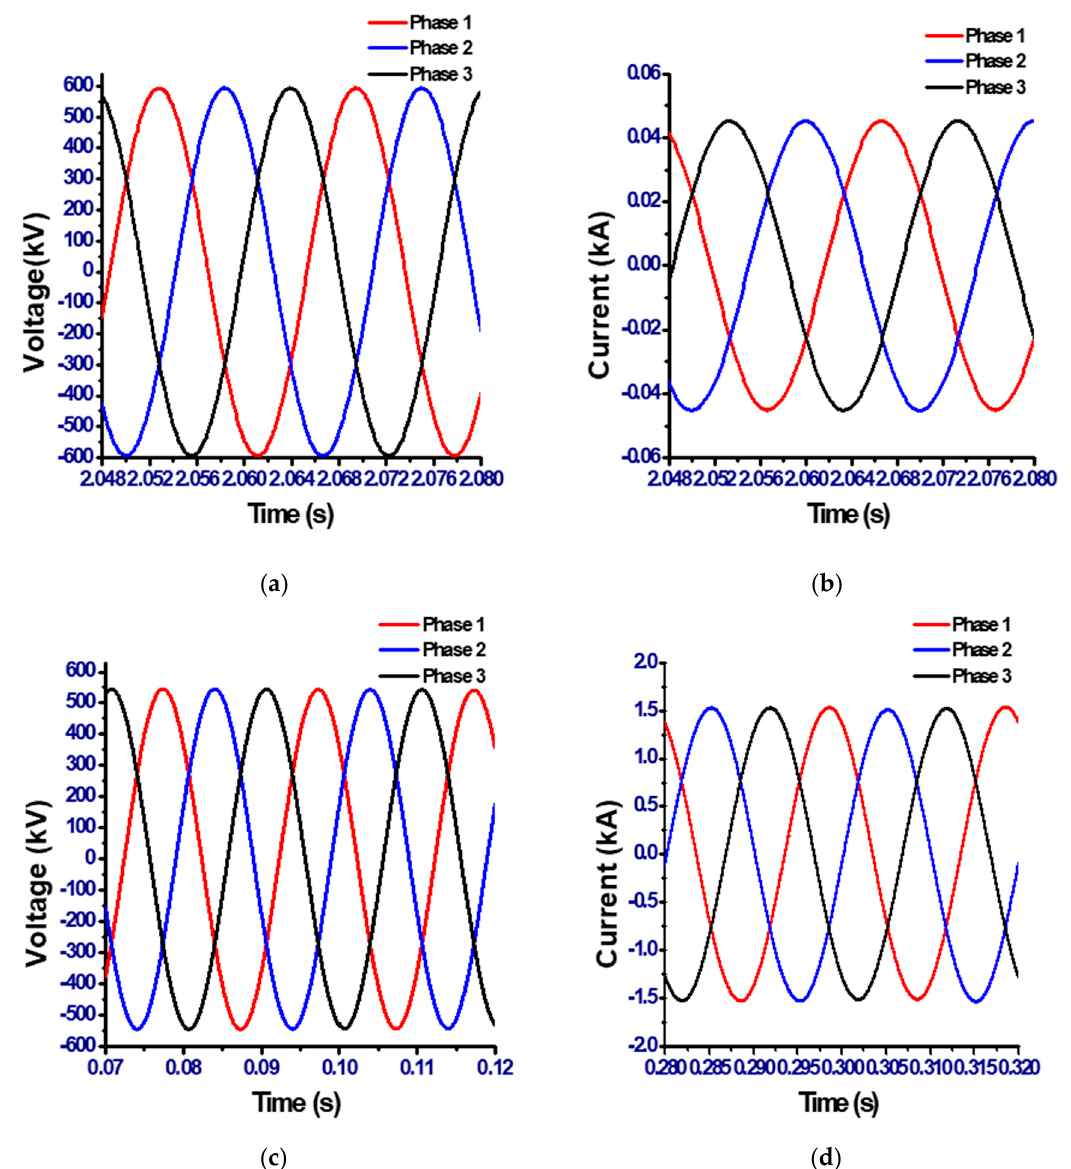
Figure 6. Results of ( a )grid side voltage (peak line-to-line); ( b ) grid side current;( c ) converter AC (peak line-to-line) side voltage; and ( d ) converter AC side current.